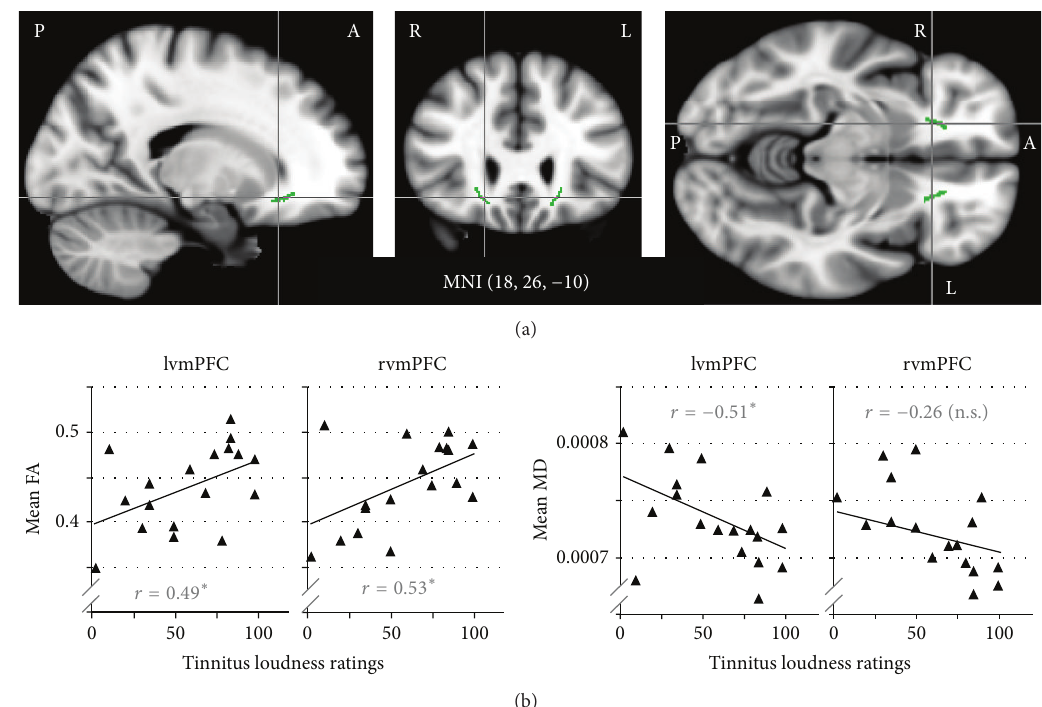
Figure 4: Correlations between DTI measures (FA and MD) and tinnitus loudness ratings in vmPFC. (a) Sagittal, coronal, and horizontal views of the anatomically defined vmPFC ROIs (green) superimposed on the MNI 152 brain template. MNI coordinates indicate the crosshairs intersection. (b) Scatter plots illustrating correlations between DTI measures and tinnitus loudness ratings in both